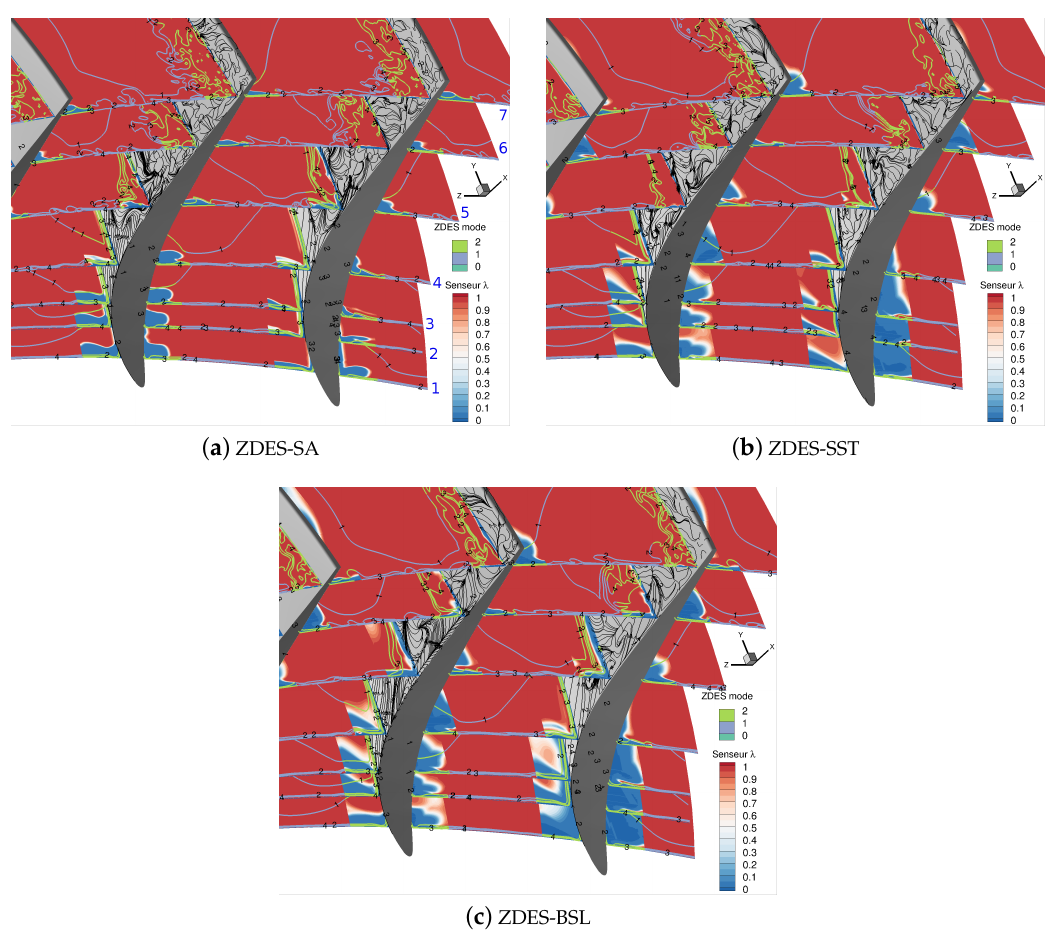
Figure 12. Contours of λ sensor in different axial planes near the rotor blade junction with the hub at the instant t = T /2, isolines of entropy variation (to highlight boundary layers and separations expansions) colored by ZDES mode, and skin-friction lines over the rotor